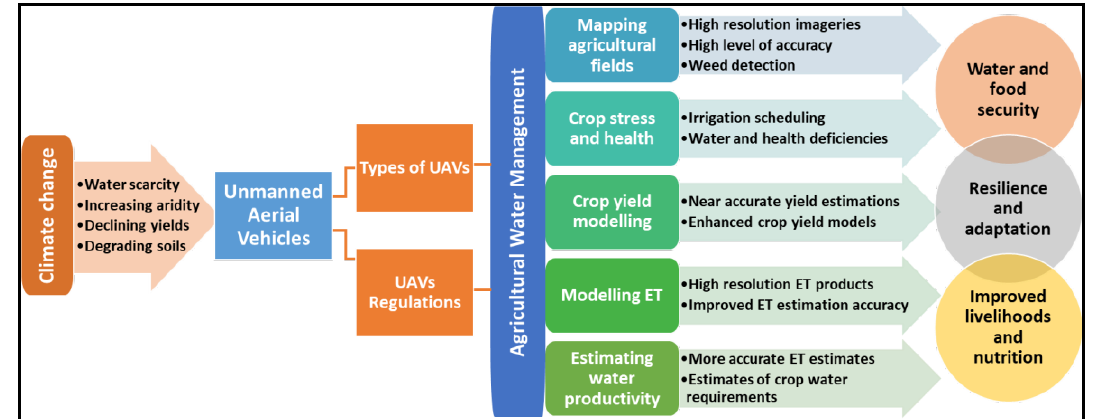
Figure 1. Methodological framework to explore the importance of UAVs in agricultural water management.